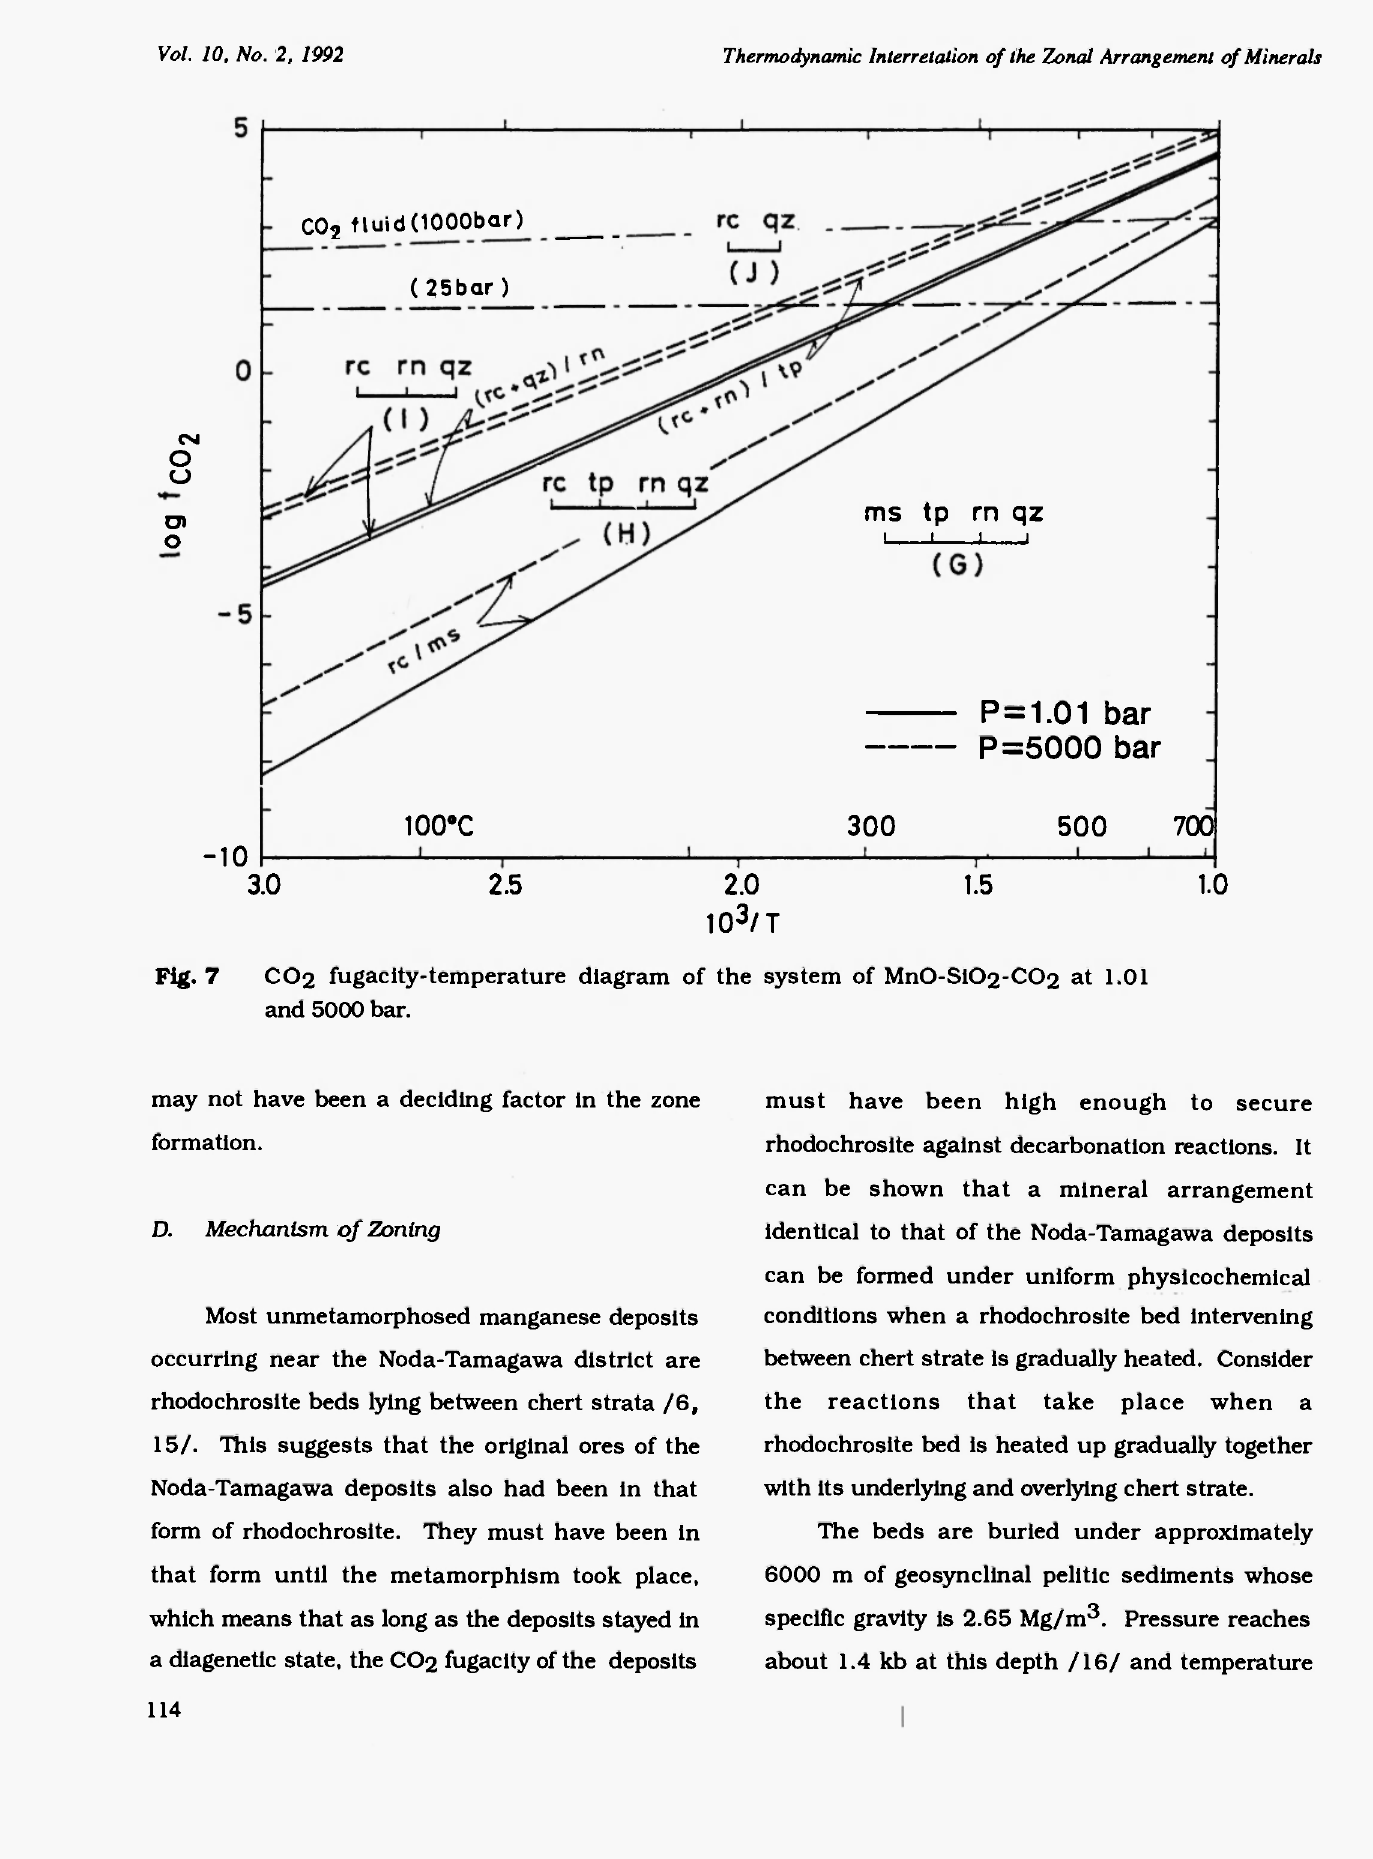
Fig. 7 CO2 fugacity-temperature diagram of the system of Mn0-Si02-CC>2 at 1.01 and 5000